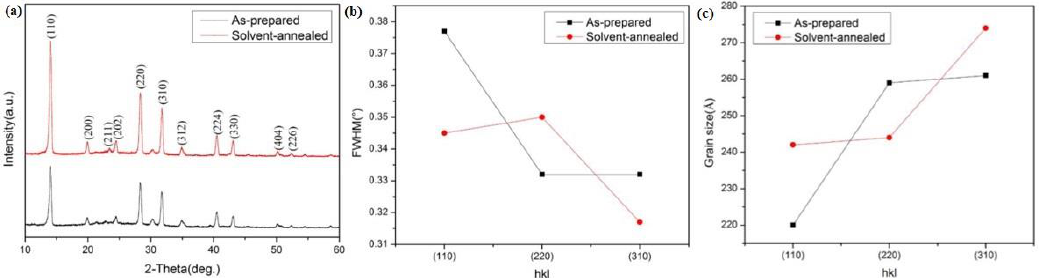
Figure 3. XRD patterns ( a ) and FWHM ( b ) and average crystalline size ( c ) of as-prepared and solvent-annealed films.